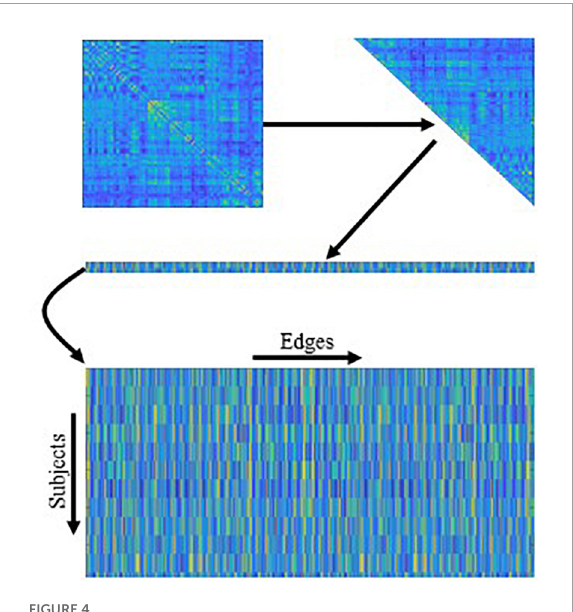
FIGURE4 The mechanism of traditional edge feature extraction in functional brain network (FBN). The network adjacency matrix from each subject is first mapped onto a vector by removing the redundant part if the matrix is symmetric, and then the vectors from all subjects are rearranged together as an input of the following feature selection